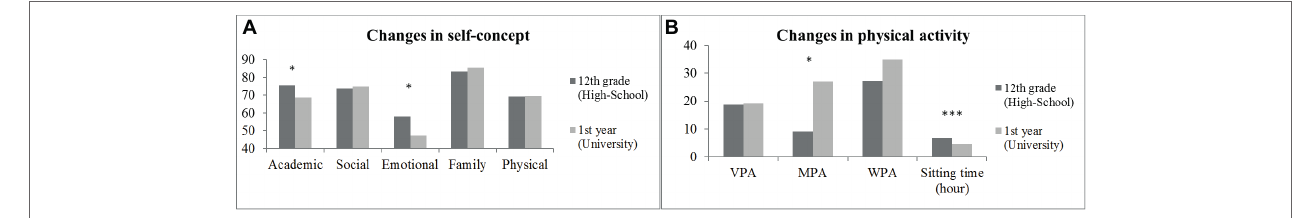
FIGURE 2 | (A) Changes in self-concept by grades. (B) Changes in physical activity by grades. * p < 0.05; *** p < 0.001.